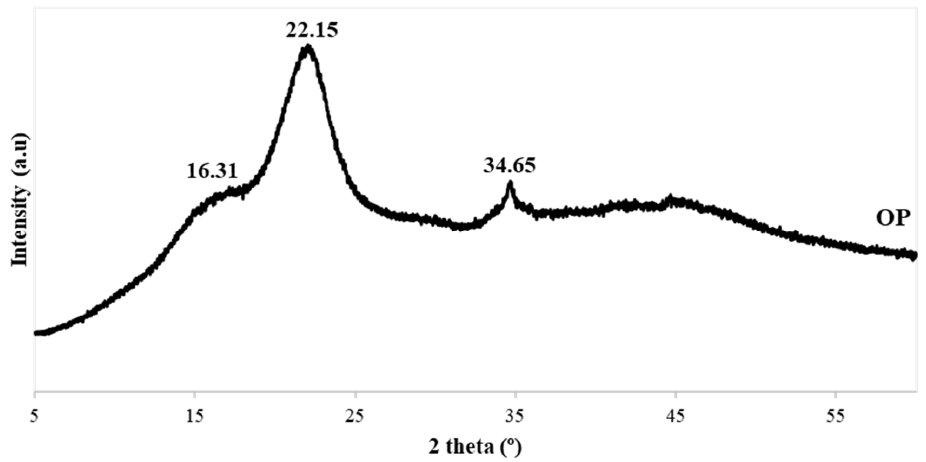
Figure 4. Olive pits XRD patterns.